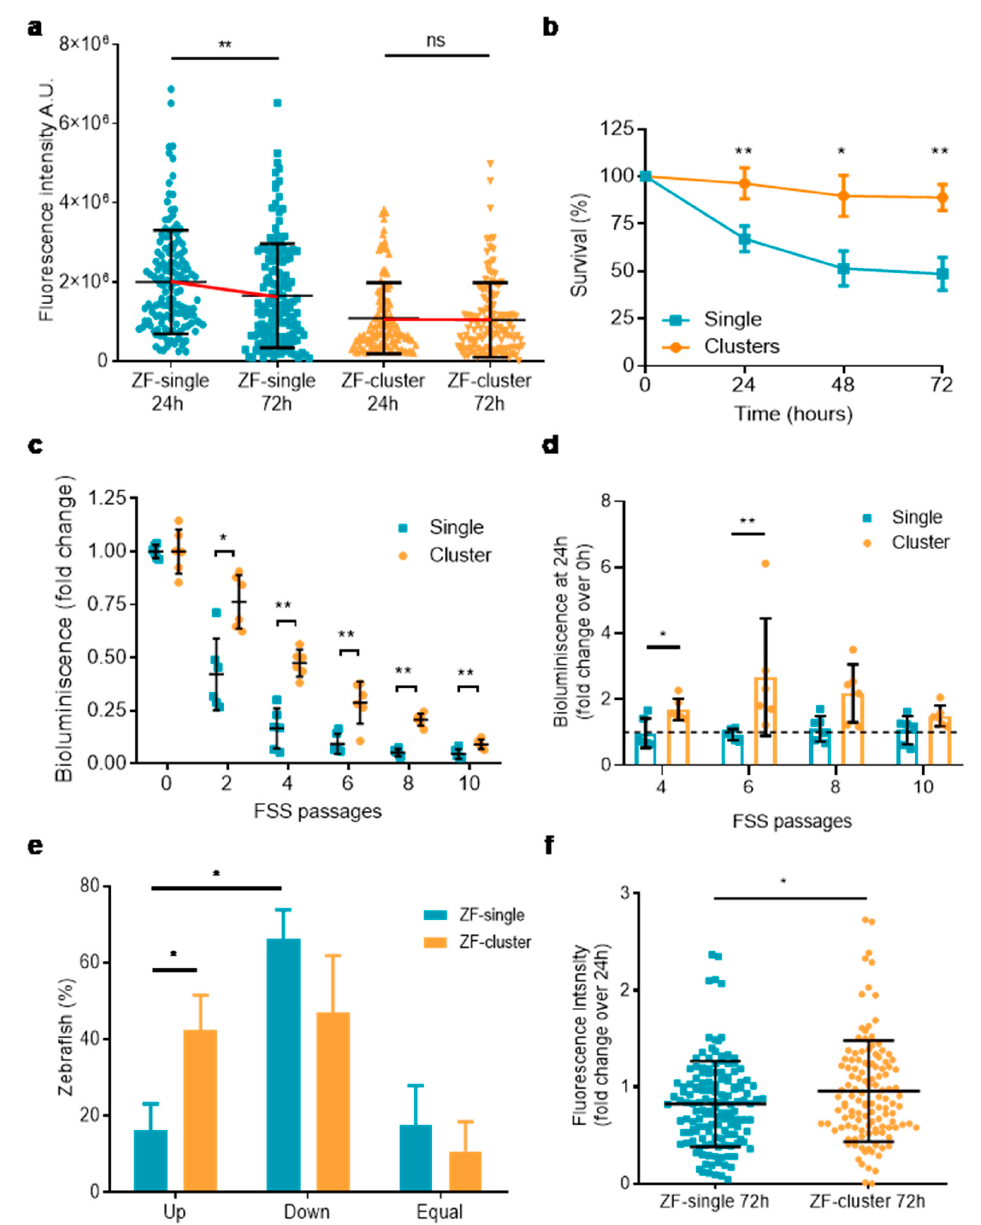
Figure 3. Time course of cell dissemination to the tail in the ZF-single and ZF-cluster xenografts. ( a ) Dot plot of the integrated fluorescence intensity of ZF-single and ZF-cluster, at 24 and 72 h post-injection ( n = 6 independent experiments). Each dot represents an individual fish; ( b ) Cell survival in the ZF-single and ZF-cluster xenografts over time. Data are expressed relative to the initial survival observed at 0 h post-injection ( n = 4); ( c ) Bioluminescent signal throughout fluid shear stress (FSS) assay. Data are represented relative to the non-FSS exposed control (P0), ( n = 3); ( d ) Bioluminescence fold change 24 h after the exposure to FSS. Data are expressed relative to the bioluminescent signal registered after finishing the FSS cycles (0 h; dotted line) ( n = 3); ( e ) Percentage of ZF-single and ZF-cluster xenografts, whose fluorescence in the tail has increased, decreased, or maintained over time ( n = 6 independent experiments); ( f ) Integrated fluorescence intensity fold change of ZF-single and ZF-cluster xenografts. Data are normalized by the integrated fluorescence intensity observed at 24 h post-injection. * p < 0.05, ** p < 0.01, ns not